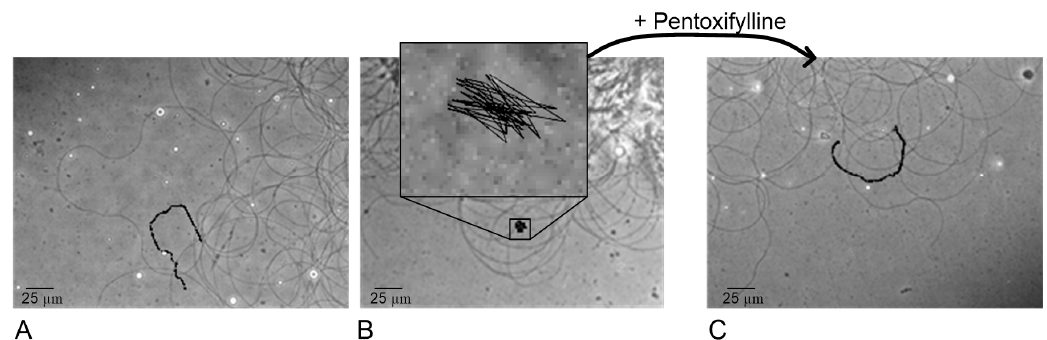
Figure 2. Tracking the end of the tail of the sperm in the control group C ( A ), group HMF6 after 6 h of exposure under hypomagnetic conditions ( B ) and the group after addition of pentoxifylline to this sample at a dilution of 1: 2.5 ( C ).